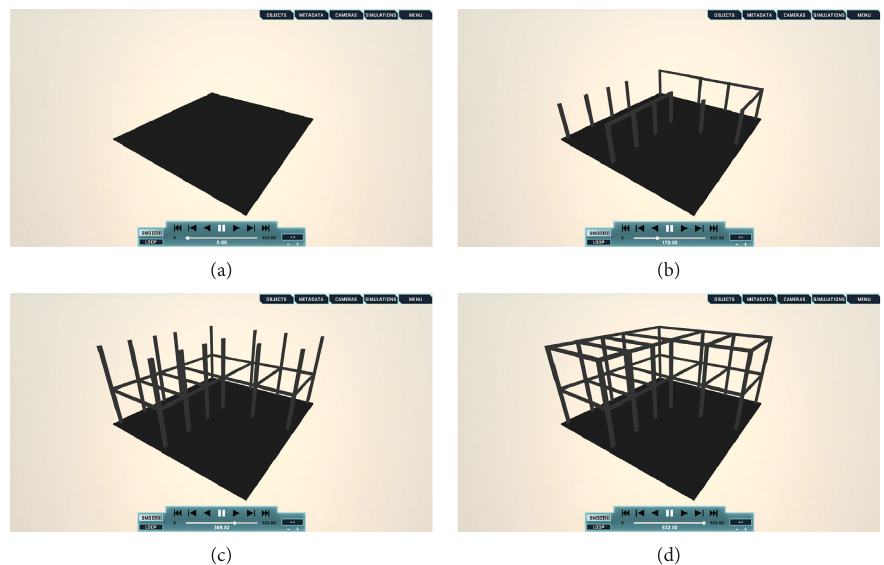
Figure 7: A sequence of screenshots that shows steel frame erection.